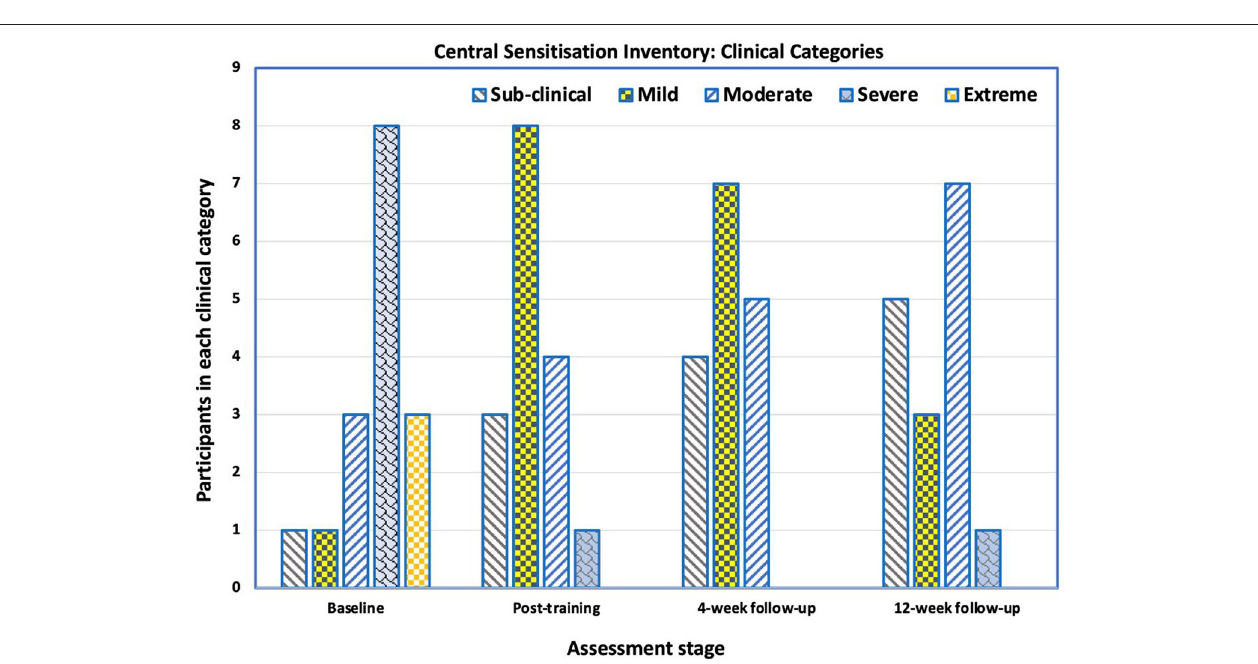
FIGURE 5 | Number of participants in each category (sub-clinical, mild, moderate, severe and extreme) of the Central Sensitization Inventory Part A (CSI-A) across the testing points—baseline, immediately after training, at 4-week follow-up and at 12-week follow-up. There was a shift from 1 out of 16 participants been categorized as having sub-clinical central sensitization pain (CSP) at baseline to 5 participants at the 12-week follow-up. At baseline, 3 of the 16 participants were categorized as having extreme CSP. At the 12-week follow-up, no participants were categorized as having extreme CSP.